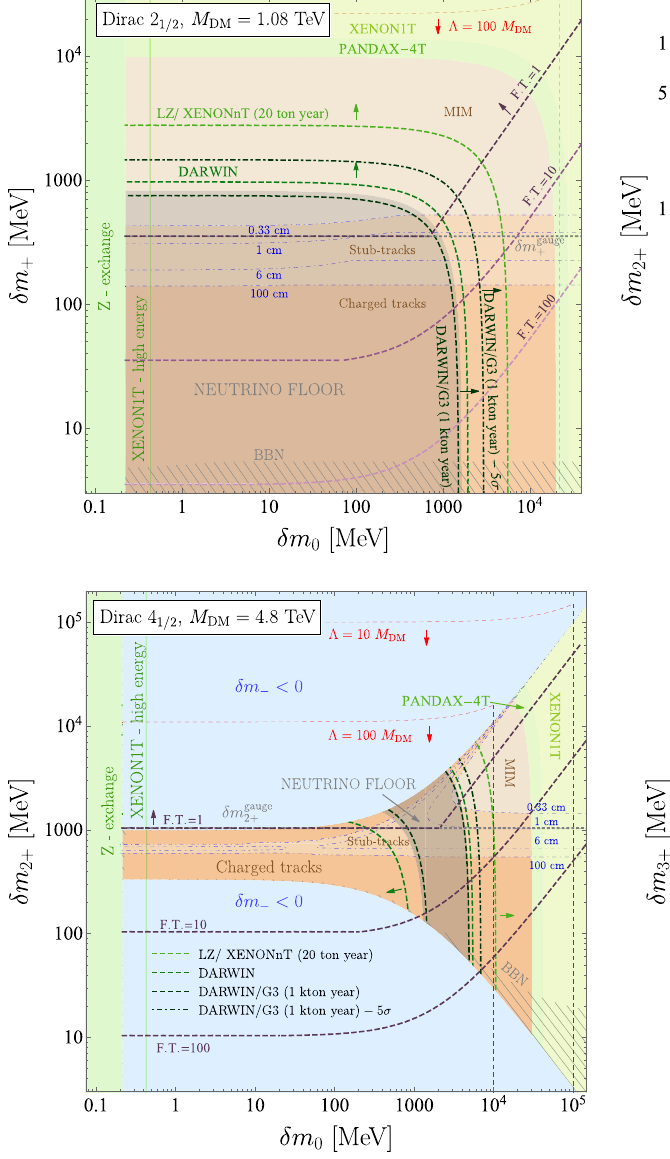
Fig. 6 Direct Detection and collider signatures in the plane δ m 0 vs. δ m Q M from the 2 1 / 2 (upper left), 3 1 (upper right) 4 1 / 2 (lower left) and 5 1 (lower right). The green shaded regions are excluded by current DD constraints on inelasticDMat small δ m 0 and on Higgs-exchange elastic scatteringatlargesplittings.GrayhatchedregionsareexcludedbyBBN constraints on the longest lived unstable particle in the multiplet. Red dashed lines delimit the range of perturbative mass splitting at fixed (cid:4) / M UV DM ratio. Light blue shaded patches are not viable because the lightest WIMP in the n -plet is not the neutral one. Dashed green lines show prospects from future high exposure xenon experiments: LZ, DARWIN and DARWIN/G3 (arrows pointing to the direction of the expected probed region). In the gray shaded region the DD sig- nal falls below the neutrino floor of xenon experiments [11,16]. The